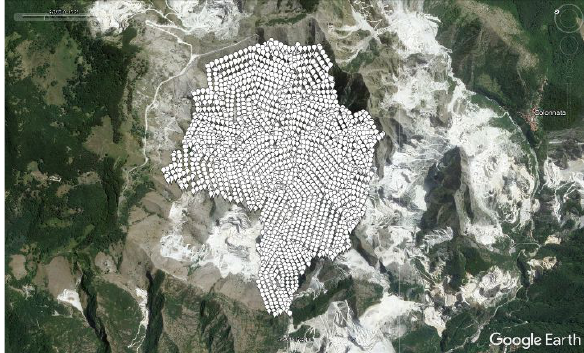
Figure 5. Spatial distribution of UAV c